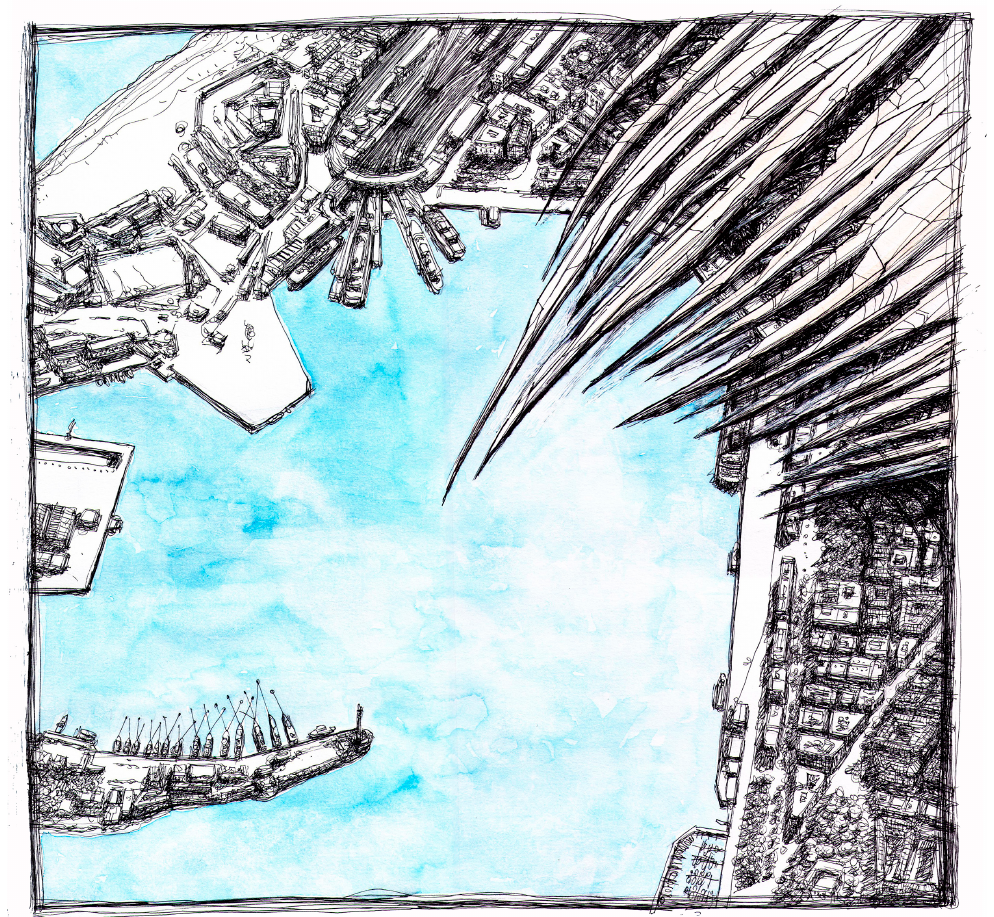
Figure 11. Michela De Domenico, Tekno